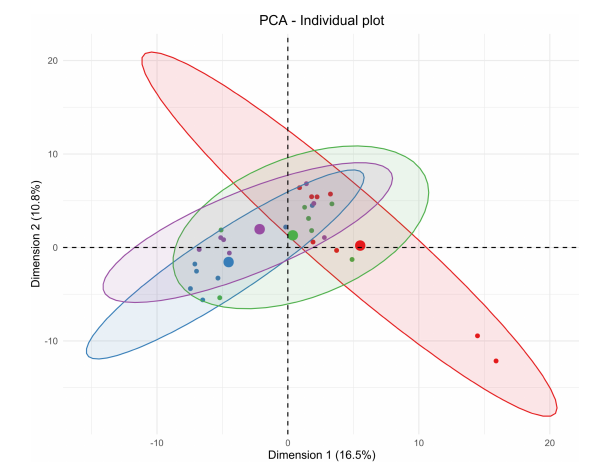
FIGURE 4 | Unsupervised multivariate analyses on CSF metabolome between control and insonified groups. Score plot of principal component analysis (PCA) constructed with metabolites within the CSF metabolome after acoustically-mediated BBB opening (BBBO). Larger dots are inertial centers of ellipses (center of a sample group) plotted based on smaller dots representing each sample individually. Red dots are control samples; Blue dots are 3-h post-BBBO samples; Green dots are 2-days post-BBBO samples; Purple dots are 1-week post-BBBO samples. Two samples having the same metabolic profile will be clustered in the same dimensional space.